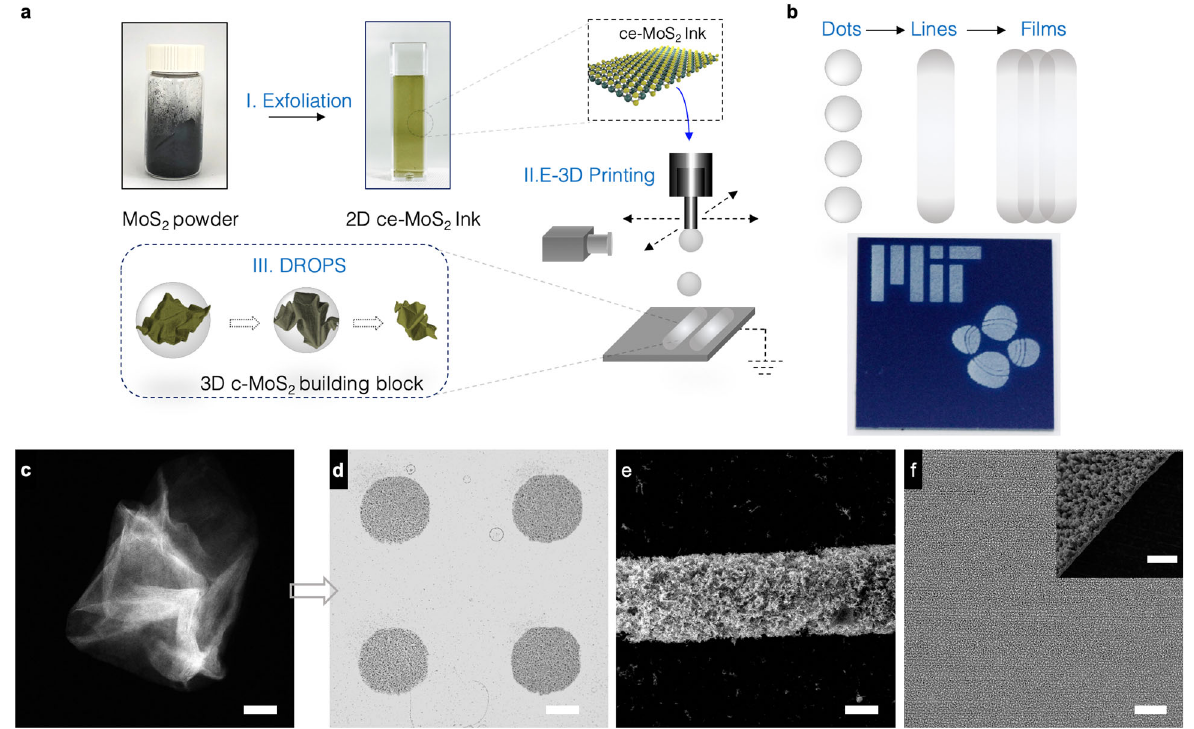
Fig. 1 E-3D printing-DROPS of MoS2 3D/3D homostructures. a Schematic illustration of the E-3D printing-DROPS of MoS 2 3D/3D homostructures shows the process scheme which comprises only three steps: (I) preparation of 2D ce-MoS 2 inks in aqueous solvents; (II) E-3D printing to create user- de fi ned layouts of 2D ce-MoS 2 inks; and (III) DROPS enables the spontaneous transformation of 2D ce-MoS 2 inks into 3D c-MoS 2 building blocks upon evaporation. b Arbitrary patterns and complex layouts such as KAUST and MIT logos through a computer-controlled X – Y stage that moves the substrates relative to the nozzle. Operation in a raster scanning mode allows circular patterns of droplets to de fi ne lines, and lines to merges into fi lms. Dewetting at room temperature results in the crumpling of 2D ce-MoS 2 into 3D nanostructures. c TEM image of the printed 3D c-MoS 2 building blocks. Scale bar is 25 nm. SEM images show an array of d dots, e individual line, and f large area of uniform thin fi lms of MoS 2 3D/3D homostructures printed with 3D c-MoS 2 building blocks. Scale bars are 1 µ m, 5 µ m,100 µ m, and 10 µ m (inset),